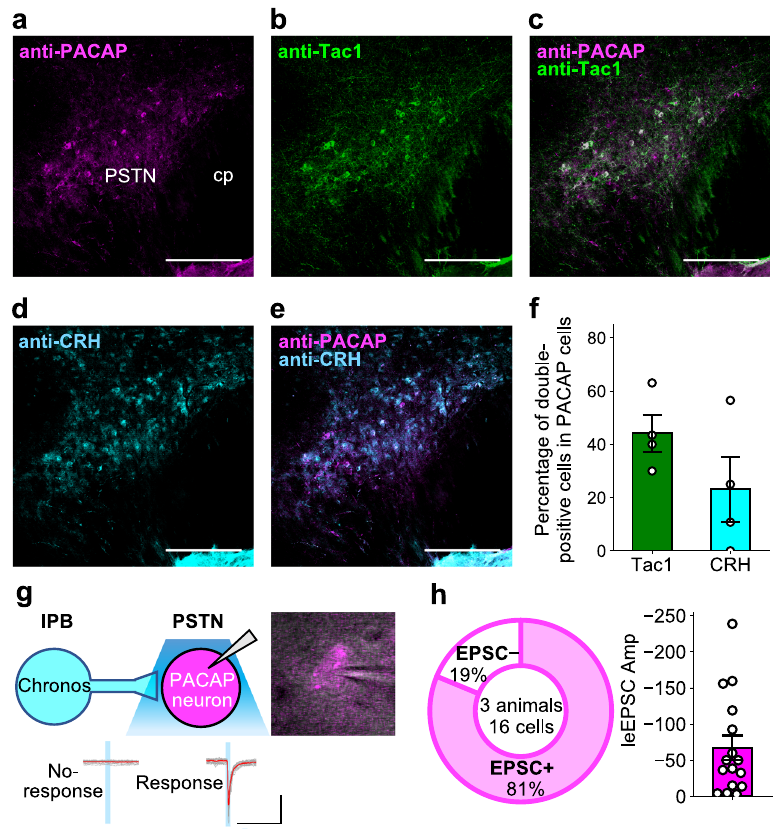
Fig. 6 | PACAP PSTN neurons overlap both Tac1 PSTN and CRH PSTN neurons. a – e PACAP, Tac1, and CRH immune-positive neurons in the PSTN. Scale bars represent 200 μ m. cp, cerebral peduncle. Experiments were repeated indepen- dentlyinatleastfourmicewithsimilarresults. f Quanti fi cationofthepercentageof PACAP neurons co-expressing Tac1 or CRH ( n =4 images). It was calculated as the ratio of the number of cells (double-positive cells/PACAP-positive